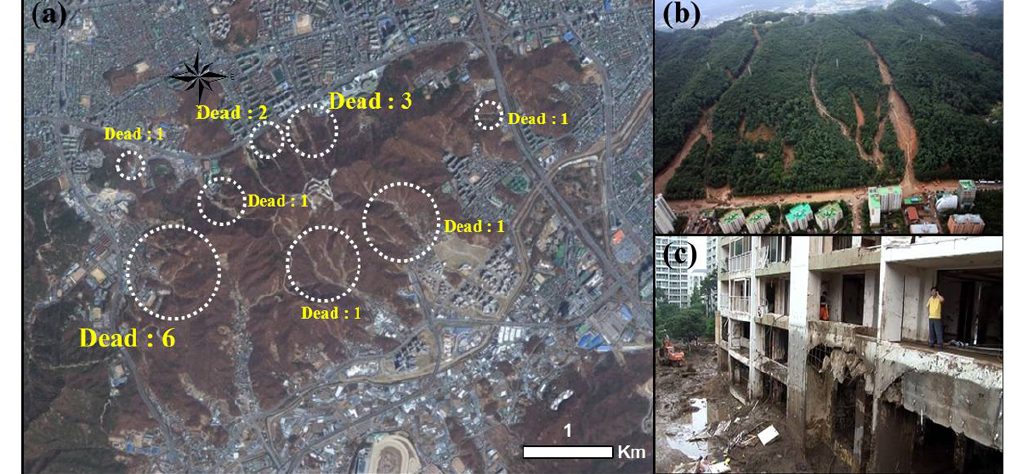
Fig. 3. Overview of landslide events on 27 July 2011: (a) the number of deaths in each region, (b) debris flow hazards, and (c) damaged apartments.